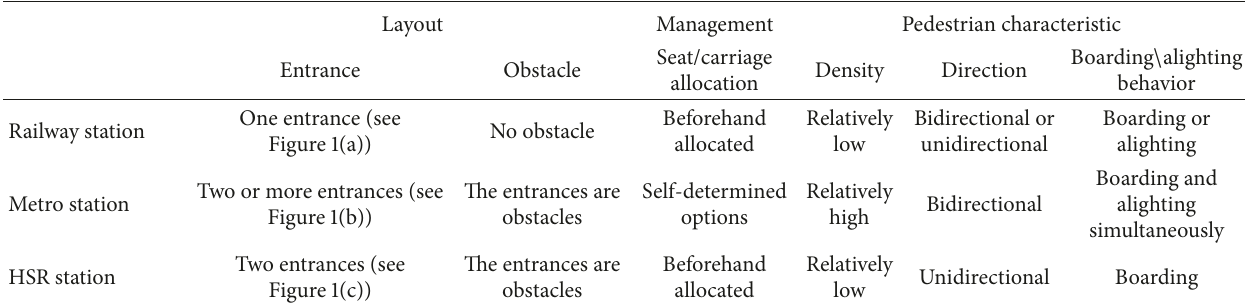
Table 1: Comparison of railway, subway and HSR station